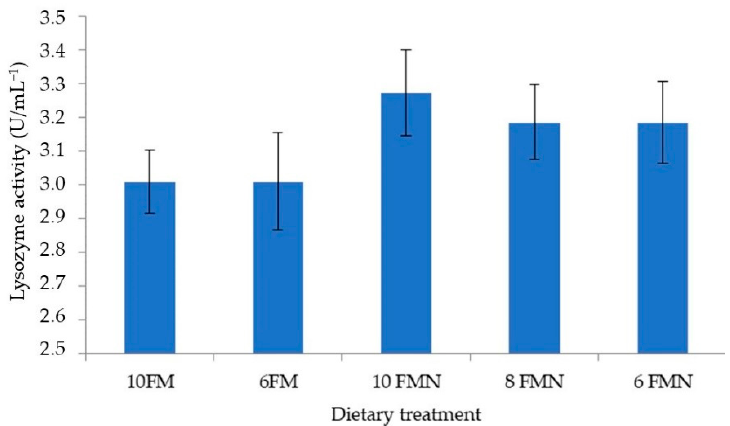
Figure 3. Pacific white shrimp (PWS) lysozyme activity (U/mL − 1 ) at the end of the 110-day growth trial. 10FM (control group; 10% FM), 6FM (6% FM and no nucleotide supplementation), 10FMN (10% FM; 0.1% nucleotides), 8FMN (8% FM; 0.1% nucleotides) and 6FMN (6% FM; 0.1% nucleotides). Values represent the mean of ten